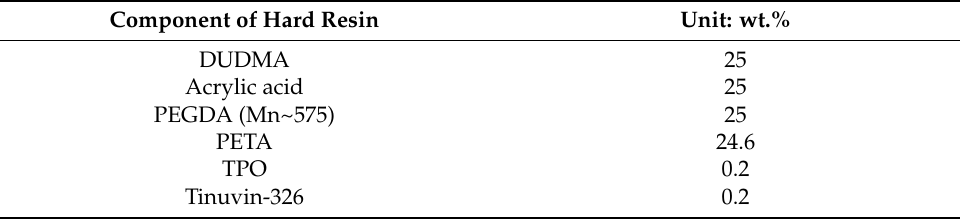
Table 2. Resin formulations for the hard material. Component of Hard